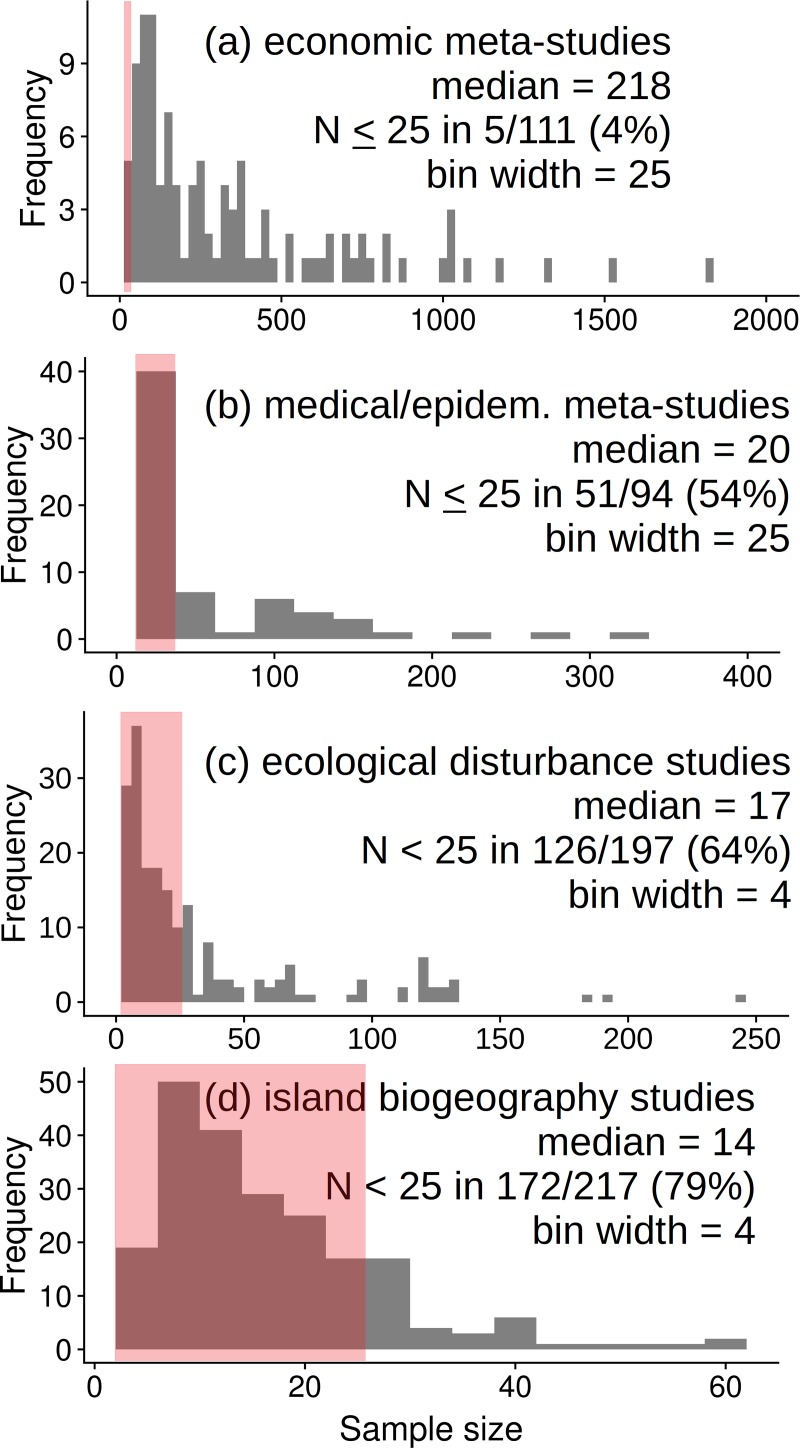
Histograms of N in research.(a) economic meta-analyses & meta-regressions; (b) medical / epidemiological meta-analyses & meta-regressions; (c) ecological analyses of disturbance [8]; and (d) biogeographical analyses of species-area relationships [9]. Please see S1 Appendix for a description of literature search methods, data, and references for (a) and (b).